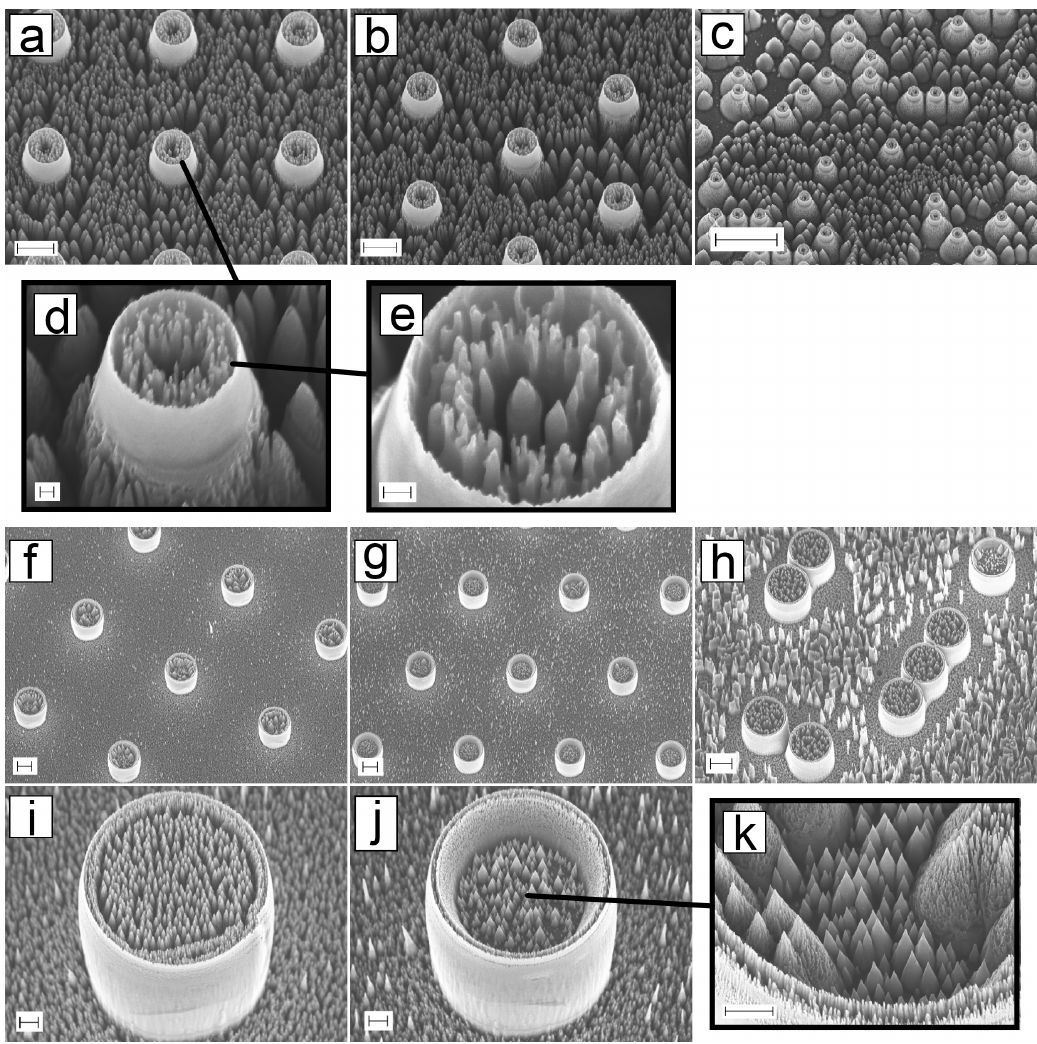
Figure 5. SEM images of silicon master for hPDMS-PDMS molding. 2 µ m pillars etched for 5 min in order to create bSi roughness with ( a ) square-grid (scalebar: 2 µ m) ( b ) hexa-grid (scalebar: 2 µ m) and ( c ) random-grid (scalebar: 10 µ m) layout. ( d ) Closeup of an individual pillar shows that the inside of the pillar is made hollow (scalebar: 200 nm). ( e ) Closer view shows the size of the roughness (scalebar: 200 nm). 20 µ m pillar in different layout; ( f ) square-grid (scalebar: 10 µ m), ( g ) hexa-grid (scalebar: 10 µ m) and ( h ) random-grid (scalebar: 10 µ m). The bSi etch for 20 µ m pillars created two kinds of structures: ( i ) pillar with roughened surface (scalebar: 2 µ m) and ( j ) pillar as a “cup” (scalebar: 2 µ m). ( k ) The bottom of the “cup” structure had sharp pyramids (scalebar: 2 µ